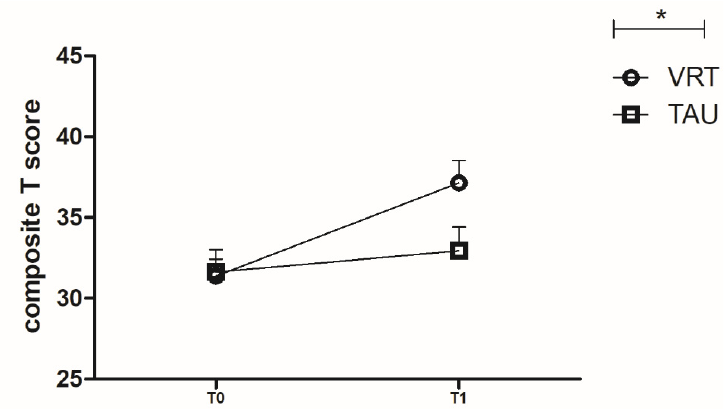
Figure 2. Legends: Figure 2 Line chart showing the changes of MCCB T scores between T0 (VRT: 31.34 ± 5.80; TAU: 31.61 ± 7.89) and T1 (VRT: 37.15 ± 7.54; TAU: 32.94 ± 8.28), p = 0.032, * p ≤ 0.05. We also compared the result of seven cognitive domains from T0 to T1 I between two groups, with a significance level of 0.05/7, Bonferroni correction.